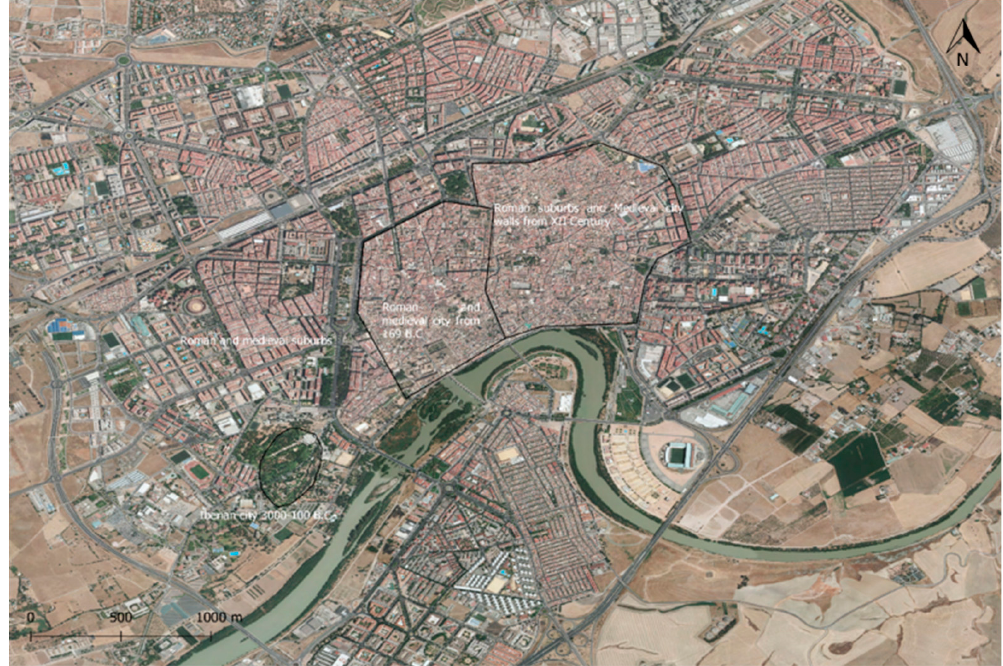
Figure 2. The three historical settlements of Cordoba. The Iberian, Roman and medieval city and the new extension of the medieval city from the 12th century. Image: Orthoimage of 2016 acquired by IGN © OrtoPNOA 2016 CC-BY 4.0 ign.es. Coordinates in the central axis of the image: 37°52´43´´,